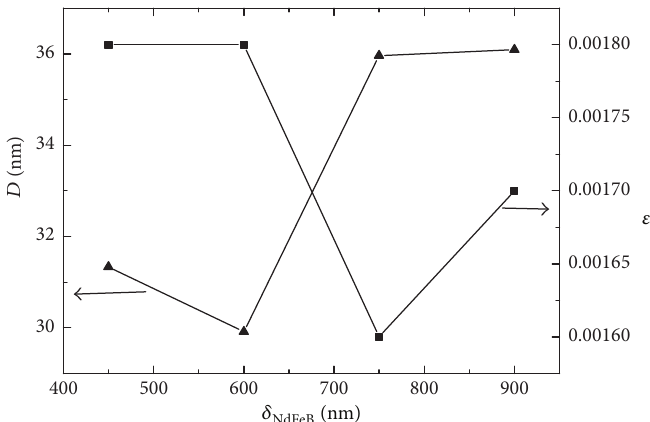
Figure 3: Variation of the grain size and strain with NdFeB layer thickness in Ta/Nd/NdFeB/Nd/Ta